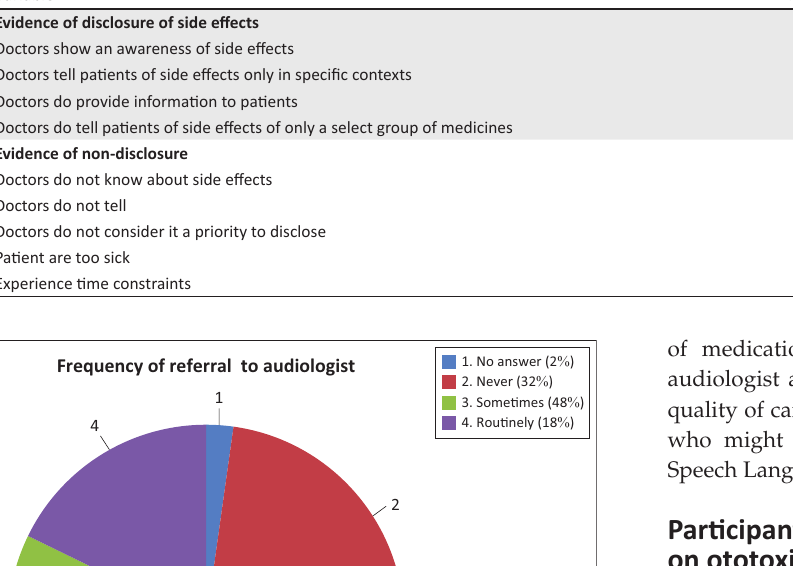
TABLE 5: Reasons for non-disclosure and disclosure of side effects of ototoxic medication (qualitative data). Variable Items counted %